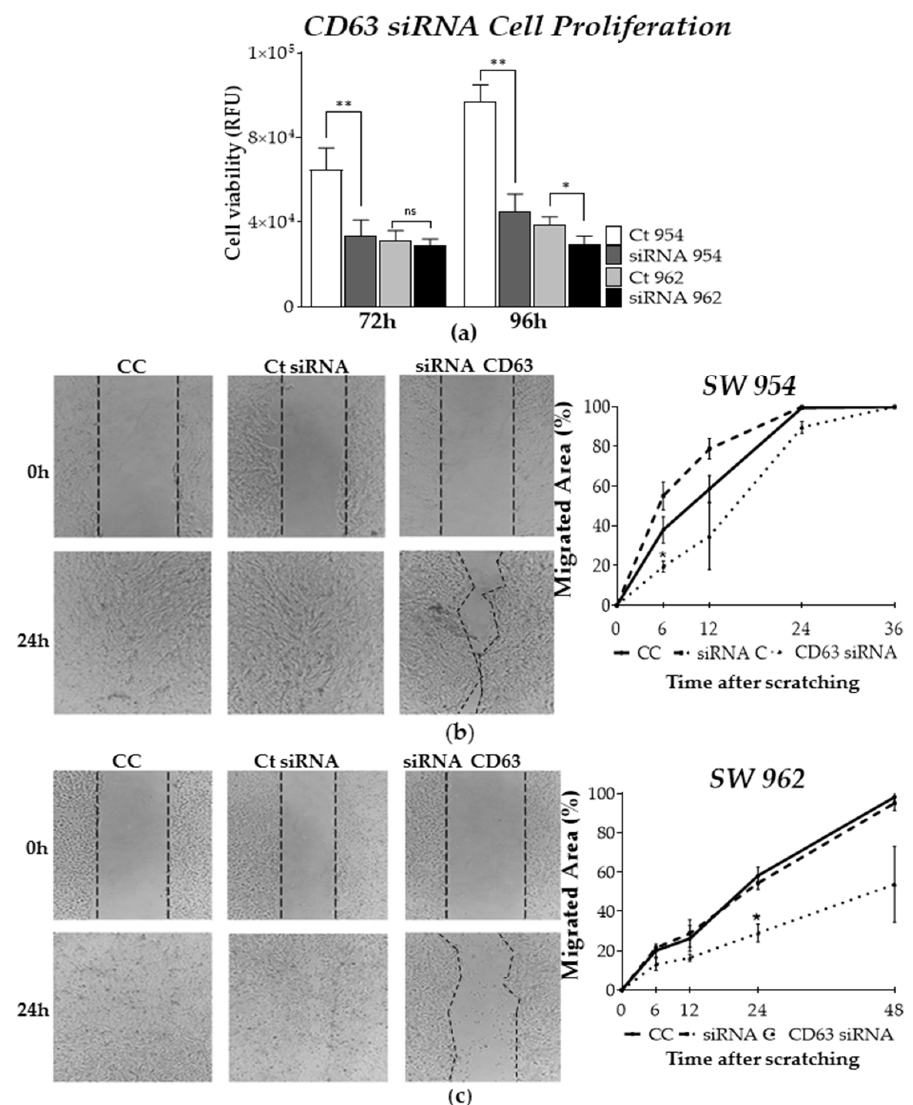
Figure 5. Effects of CD63 silencing on SW954 and SW962 cell proliferation (viability) and migration. ( a ) Cell viability measurements of CD63-siRNA transfected and control cells at different time points (* p < 0.05; ** p = 0.0022; ns = not significant). Silencing of CD63 in SW954 ( b ) and SW962 ( c ) cells inhibits their motility, as determined by the scratch wound healing assay at 6 h ( p < 0.05) and 24 h ( p < 0.05) after scratch, respectively. Representative photomicrographs (original magnification × 10) of scratched wells at time 0 h and 24 h are shown. Experiments with both cells were carried out using siRNA-treated cells for 48 h, and cell migration analysis was carried out until total wound healing of control groups (36 h and 48 h for 954 and 962 cells, respectively). Data are shown as mean values ± standard deviation ( ± SD) or percentage (%). CC: Non-transfected cells, siRNA C: siRNA control (eGFP-siRNA) and CD63: